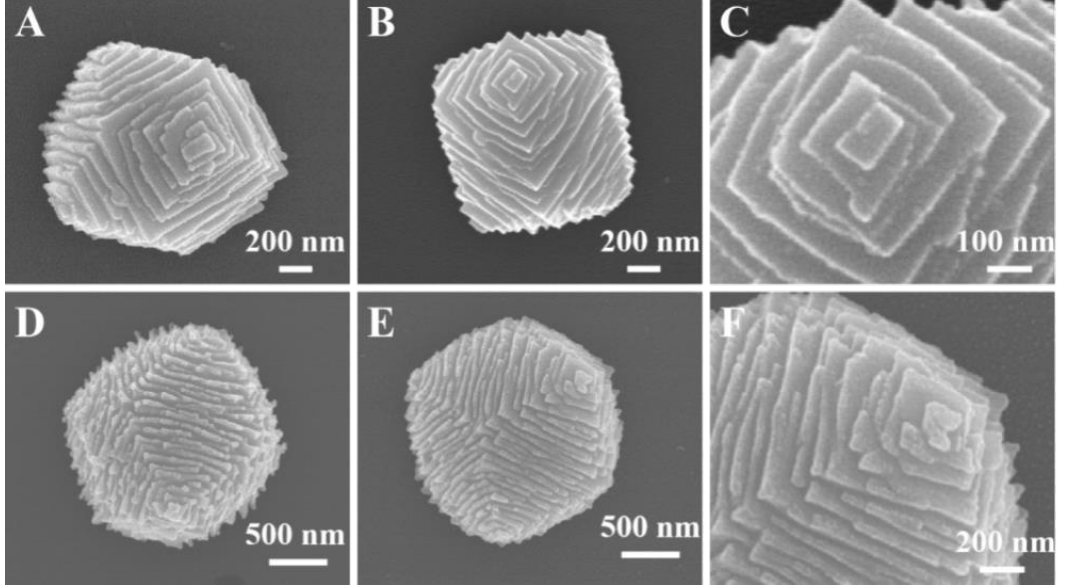
Figure 2. Representative SEM images of HSANs synthesized by a 5 M AgNO 3 aqueous solution with ( A – C ) 30 min and ( D – F ) 40 min UV irradiation time.